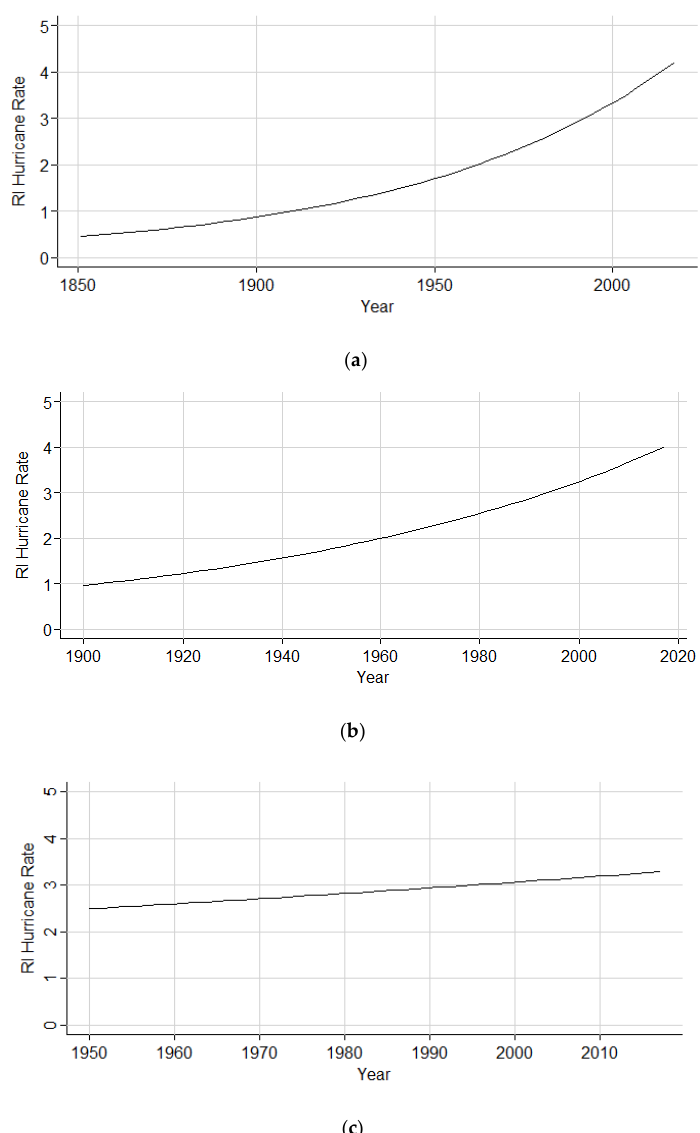
Figure 8. Incidence rate ratios of RI storms initiating RI within the North Atlantic sub-basin over time described by the Poisson regression model ( a ) between 1851-2017, ( b ) depicting 1900-2017, and ( c ) 1950-2017. Table 6. Coe ffi cient estimates, p -values, and chi-square p -values on the residual deviance for RI storms initiating their first cycle of RI within the North Atlantic